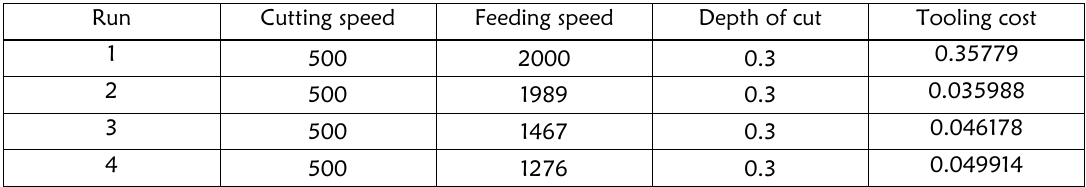
Table 5: GA optimization